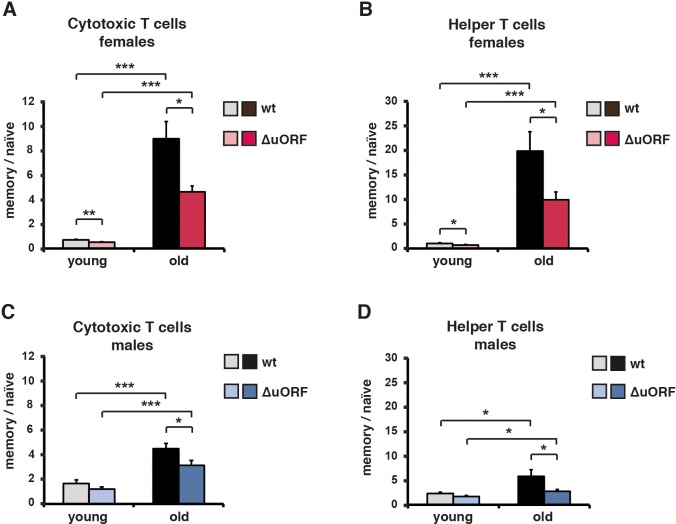
Ageing-associated increase of the memory/naïve T-cell ratio is attenuated in C/EBPβΔuORF mice.The ratio between Cd44high memory T cells and Cd44low/Cd62Lhigh naïve T cells in blood is shown for young (5 months) and old (female 20 months, male 22 months) (A, B) females and (C, D) males for both (A, C) Cd8+ cytotoxic and (B, D) Cd4+ helper T cells as was determined by flow cytometry (wt females, n = 10 young, n = 12 old; wt males n = 12 young and old; C/EBPβΔuORF females, n = 10 young, n = 12 old; C/EBPβΔuORF males, n = 12 young and old). P-values were determined by Student’s t-test, *p<0.05; ***p<0.001.